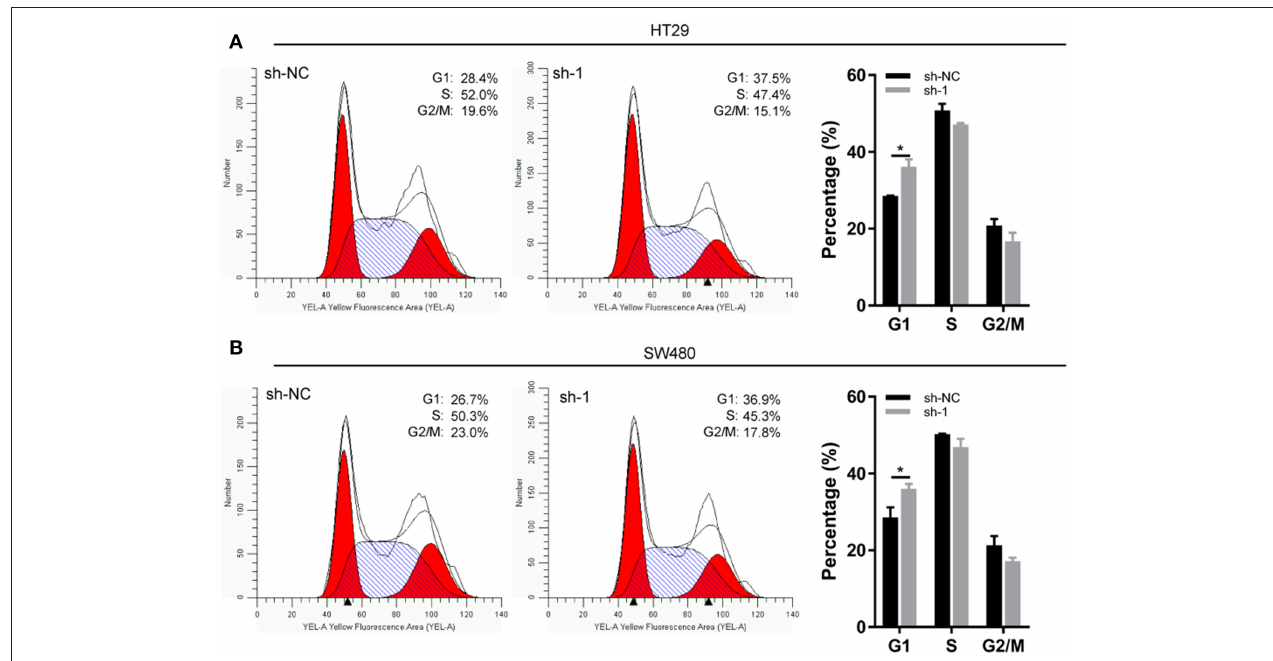
FIGURE 4 | EXOSC5 Knockdown inhibits G1/S transition of CRC cell. (A,B) Representative images of the cell cycle assays in HT29 (A) and SW480 cells (B) after transfection with sh-NC or sh-EXOSC5. Cells were stained with PI and analyzed by flow cytometry. (* p < 0.05).